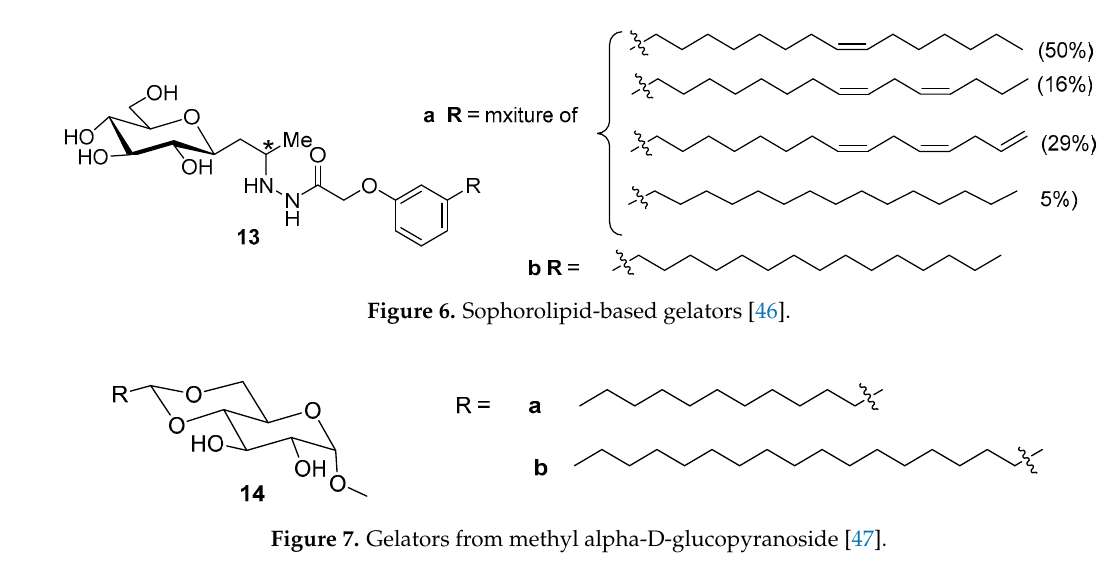
Figure 7. Gelators from methyl alpha-D-glucopyranoside [47].